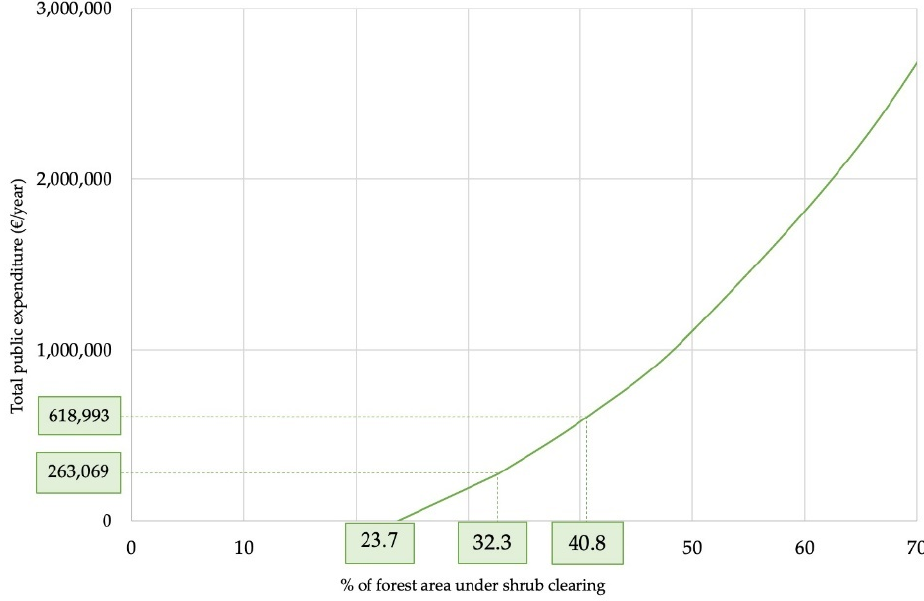
Figure 2. Public expenditure curve for shrub clearing by forest owners in the parish as a whole. Remember that the 111.5 EUR/ha would be paid to the whole of the 32.3% of land under shrub clearing for this payment level, including the 22.0% that would be under shrub clearing even without payment. This means that a part of the payment would not have an additional effect when compared with the policy-off situation. Doing it otherwise would mean rampant administrative (transaction) costs for policy administration, as it would imply, for example, identifying all owners that are already doing shrub clearing and discriminating against them, which would also raise ethical